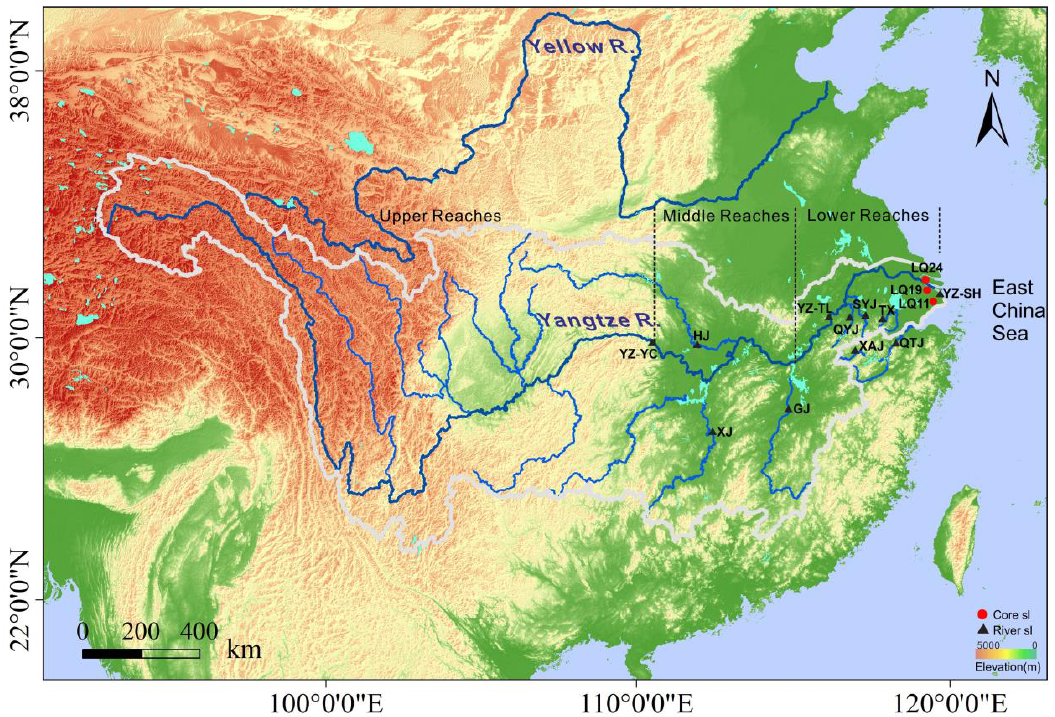
Figure 1. Sampling locations of the surface sediment in the Modern River and borehole sediment in the Yangtze Delta. R. = River, sl = Sampling location, YZ-YC = Yangtze mainstream near Yichang City, YZ-TL = Yangtze mainstream near Tongling City, YZ-SH = Yangtze mainstream near Shanghai City, GJ = Ganjiang River, XJ = Xiangjiang River, HJ = Hanjiang River, QYJ = Qingyijiang River, SYJ = Shuiyangjiang River, TX = Tiaoxi River, XAJ = Xinanjiang River, QTJ = Qiantang River.